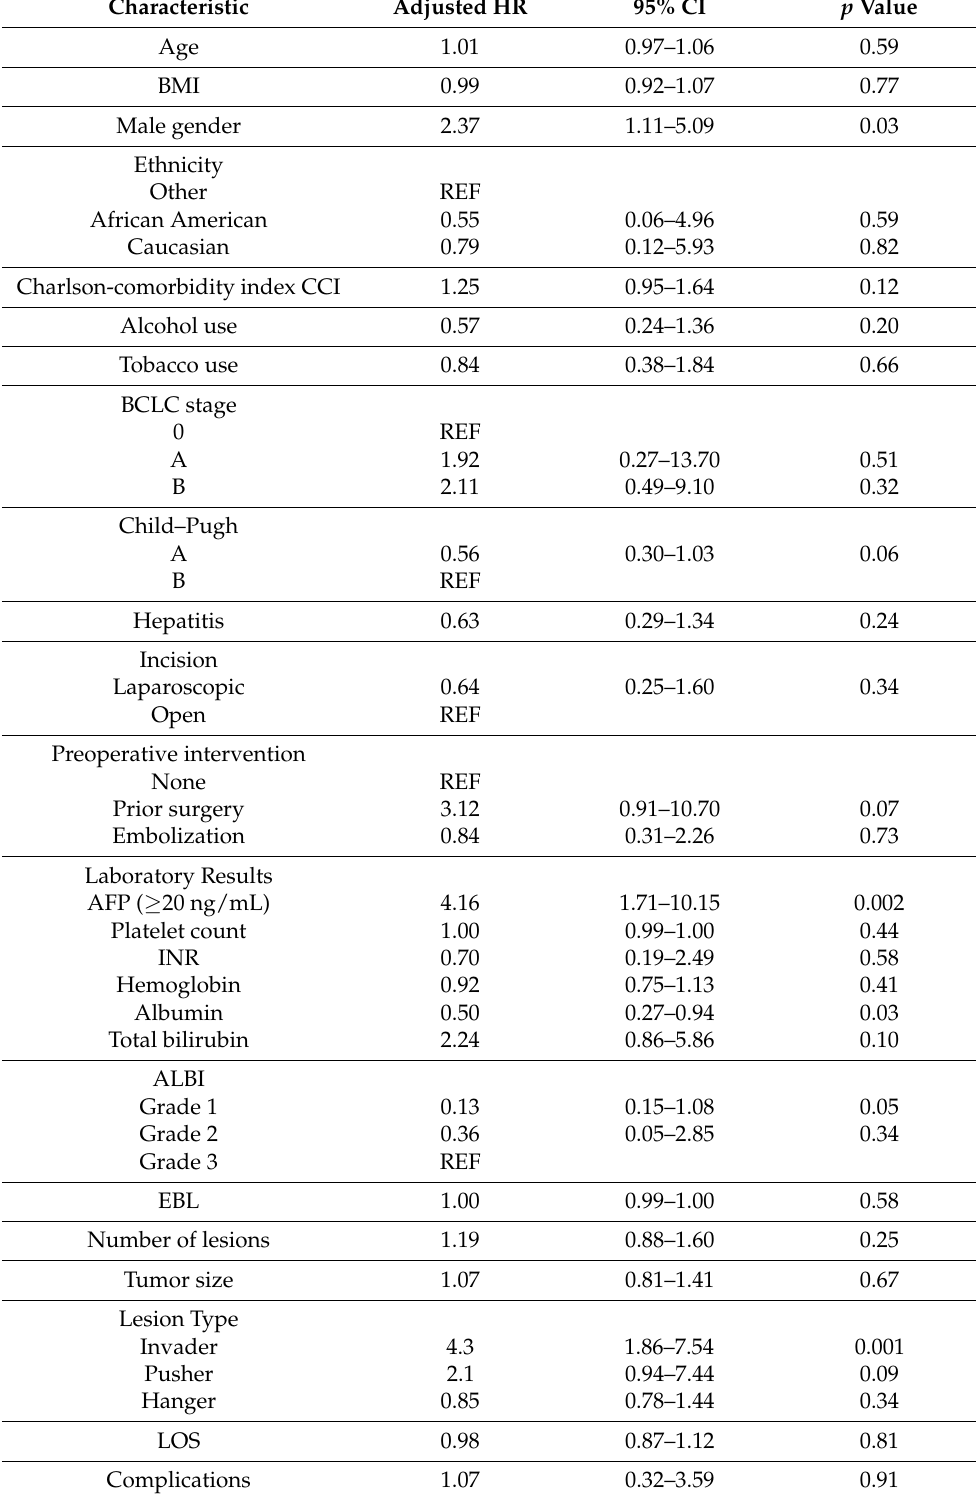
Table 3. Prognostic factors of PFS univariate